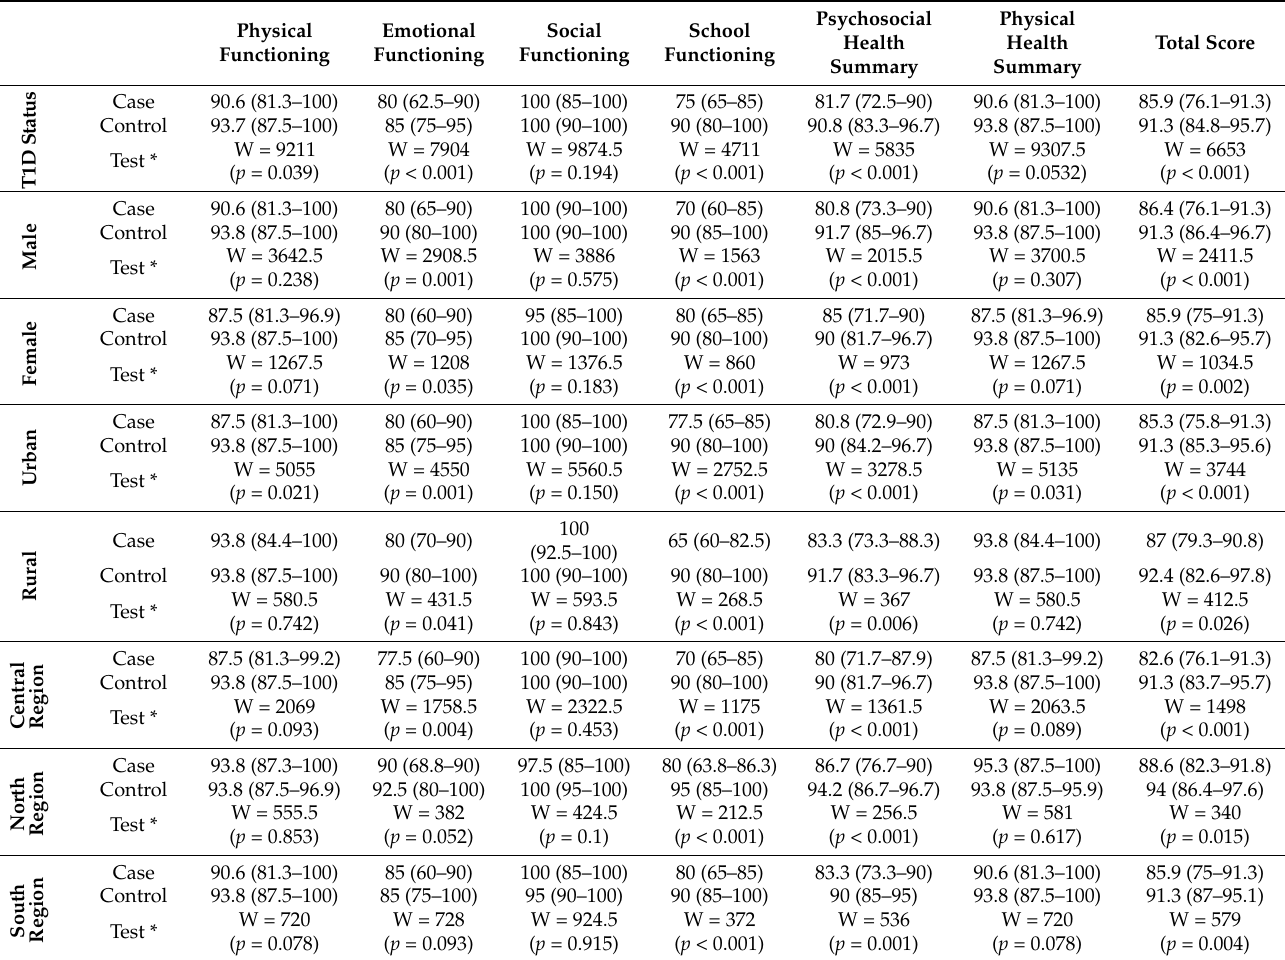
Table 2. Medians (IQR) of scores by sociodemographic status and by case/control